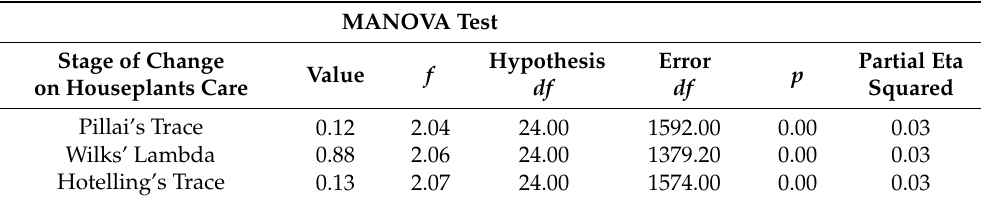
Table 3. Multivariate Tests of Differences (MANOVA) of mental well-being and trait mindfulness amongst five Stage of Change groups .